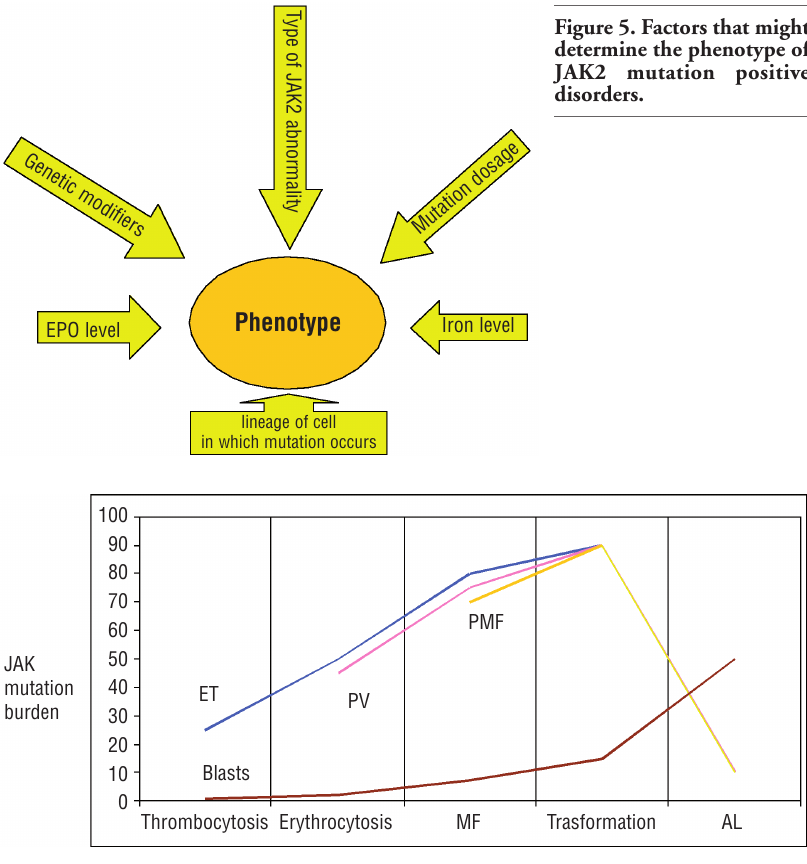
Figure 6. JAK2 mutation burden during progression of MPNs. AL: acute leukemia, ET: essential thrombocythemia, MF: myelofibrosis, PMF: primary myelofibrosis, PV: poly- cythemia